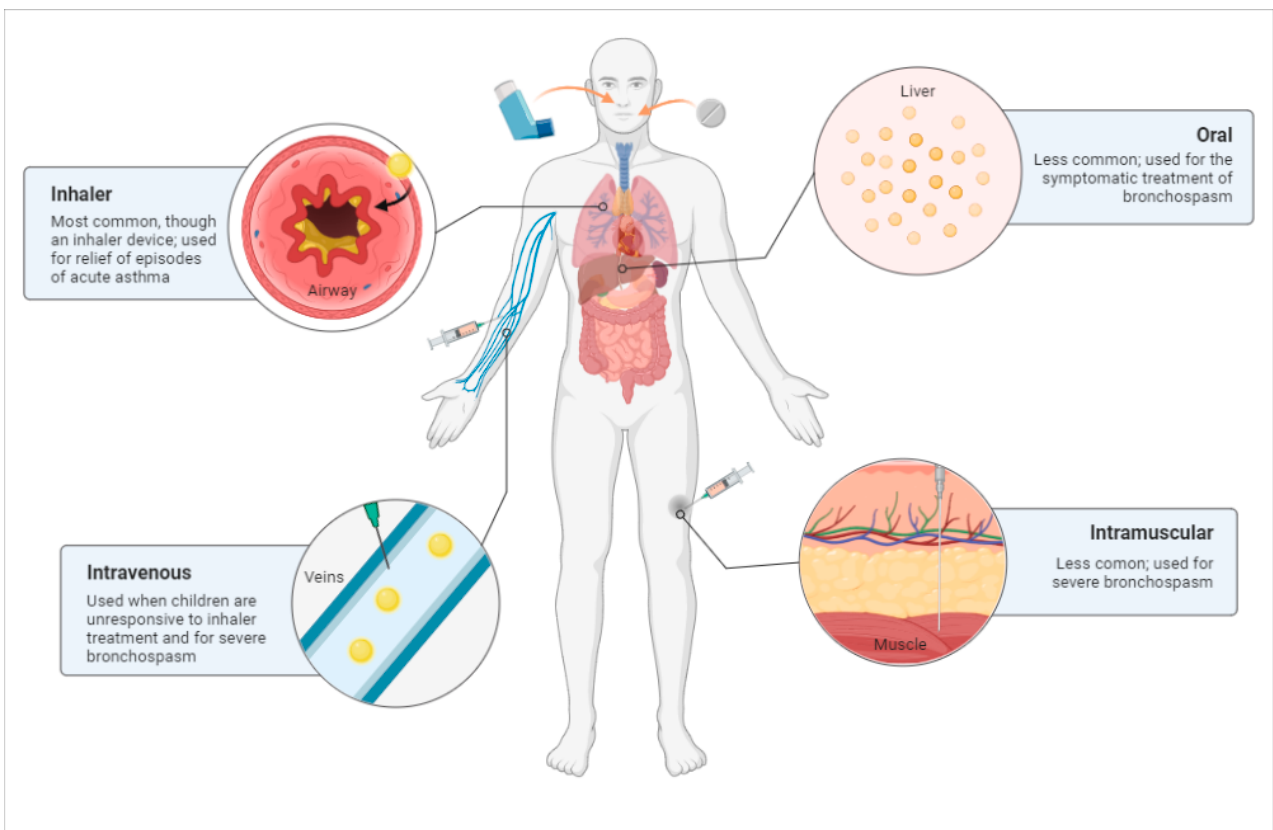
Figure 3. Main routes of administration of salbutamol: inhalation, oral, intravenous, and intramuscular. Created with BioRender.com. Available online: http://biorender.com/ (accessed on 11 October 2022). Table 2. Recommended dosages for salbutamol formulations..